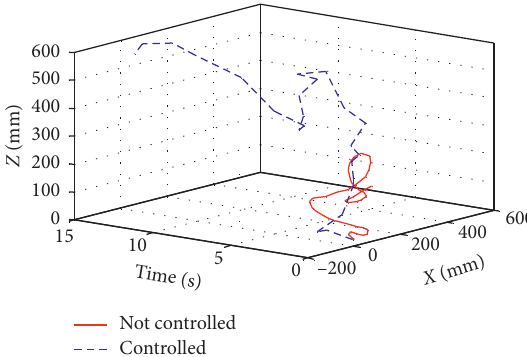
Figure 18: Flight trajectory of two flapping-wing drones along time.